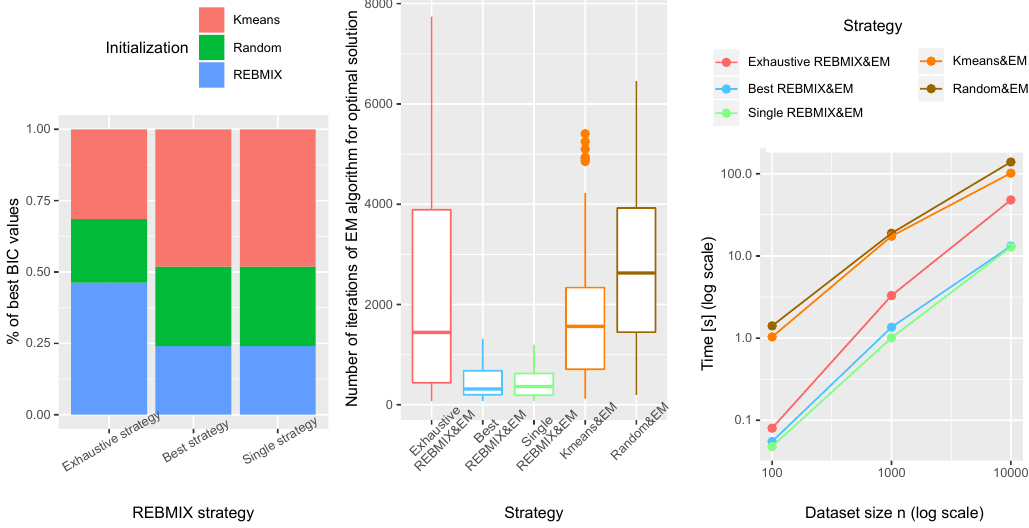
Figure 4. Benchmarking different REBMIX&EM strategies vs. Kmeans&EM and Random&EM.